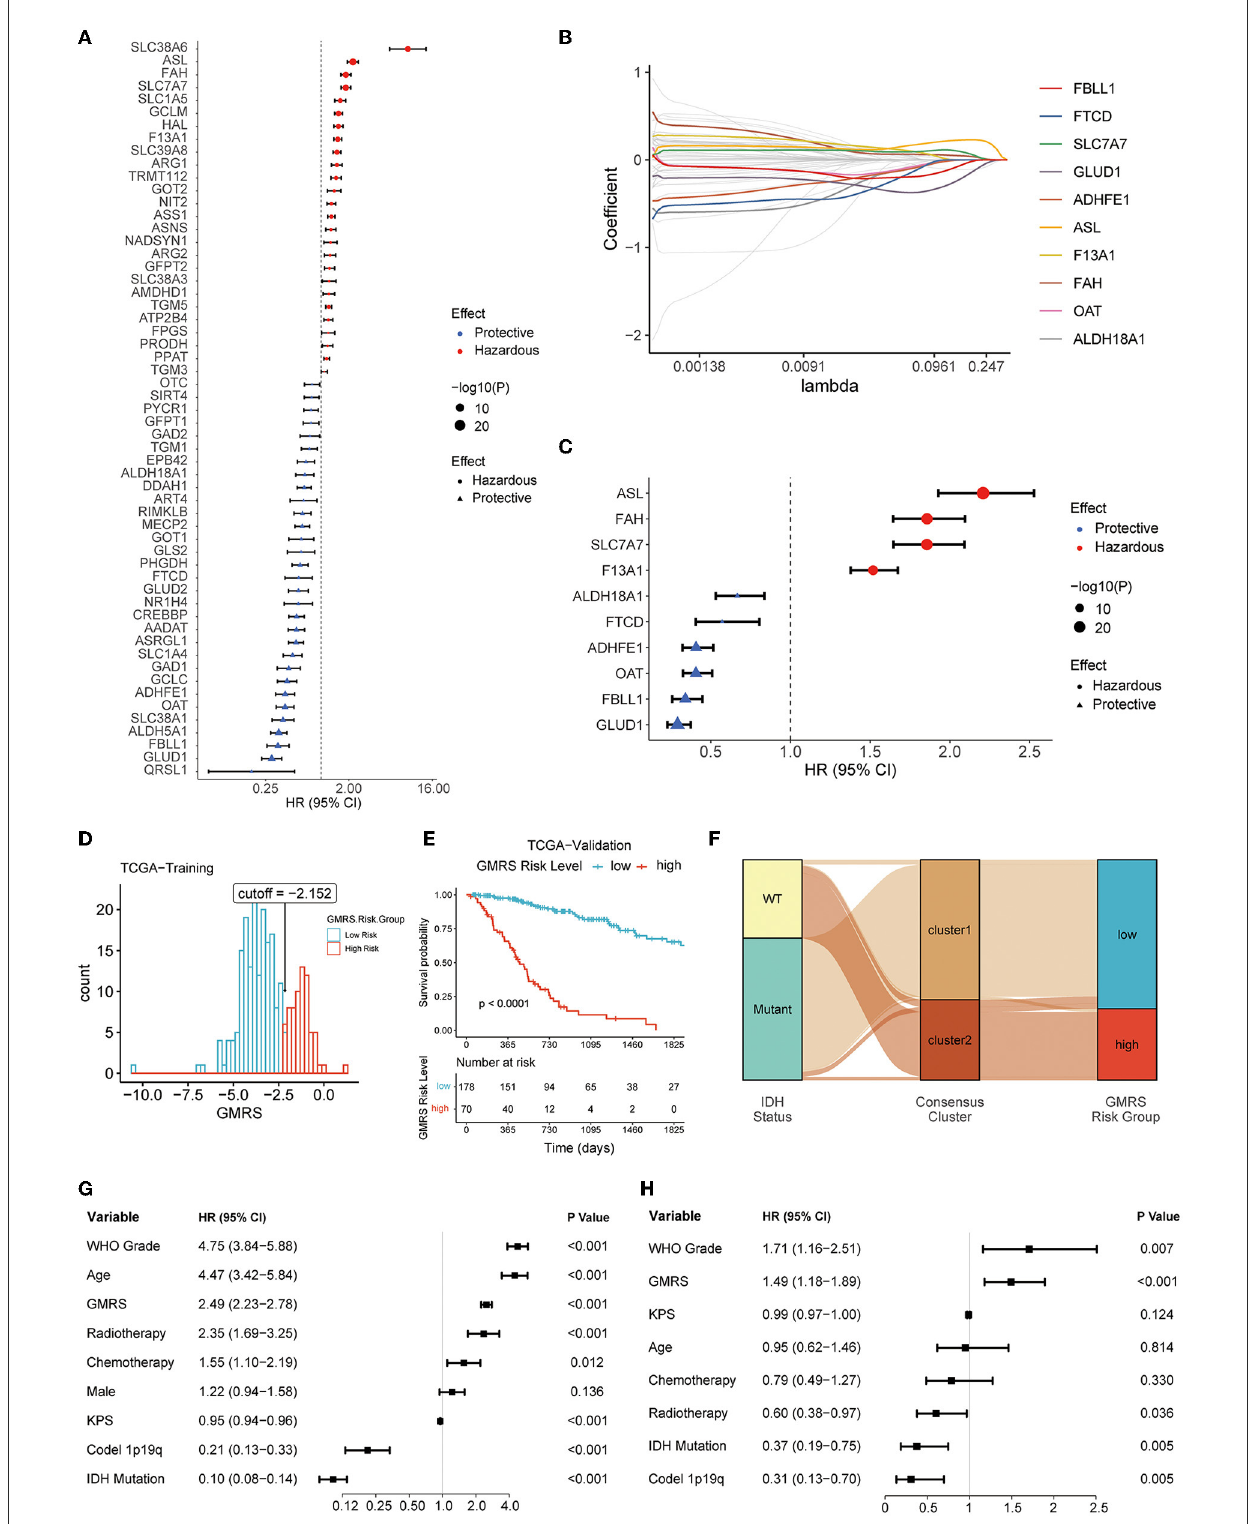
FIGURE6 Screening of prognostic GMRGs. (A) Forest plot for preliminary screening prognostic GMRGs; (B) LASSO Cox regression for screening stable prognostic GMRGs; (C) forest plot for displaying 10 robust prognostic GMRGs; (D) optimal cutoff value of GMRS in the TCGA training group; (E) K–M curves for assessing GMRS in TCGA-validation group; (F) alluvial plot for showing the connection between clusters and GMRS risk groups; (G) univariate Cox regression of clinical variables in the entire TCGA cohort; and (H) multivariate Cox regression of clinical variables with a p -value of < 0.1 in univariate Cox regression in the entire TCGA cohort. GMRG, glutamine metabolism-related gene; LASSO, least absolute shrinkage and selection operator; GMRS, glutamine metabolism risk score; TCGA, The Cancer Genome Atlas; CGGA, Chinese Glioma Genome Atlas; WCH, West China